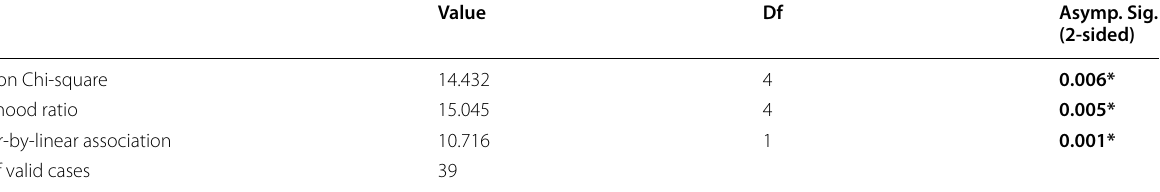
Table 3 Glasgow Outcome Score (GOS) in relation to CT on admission: with haematoma thickness